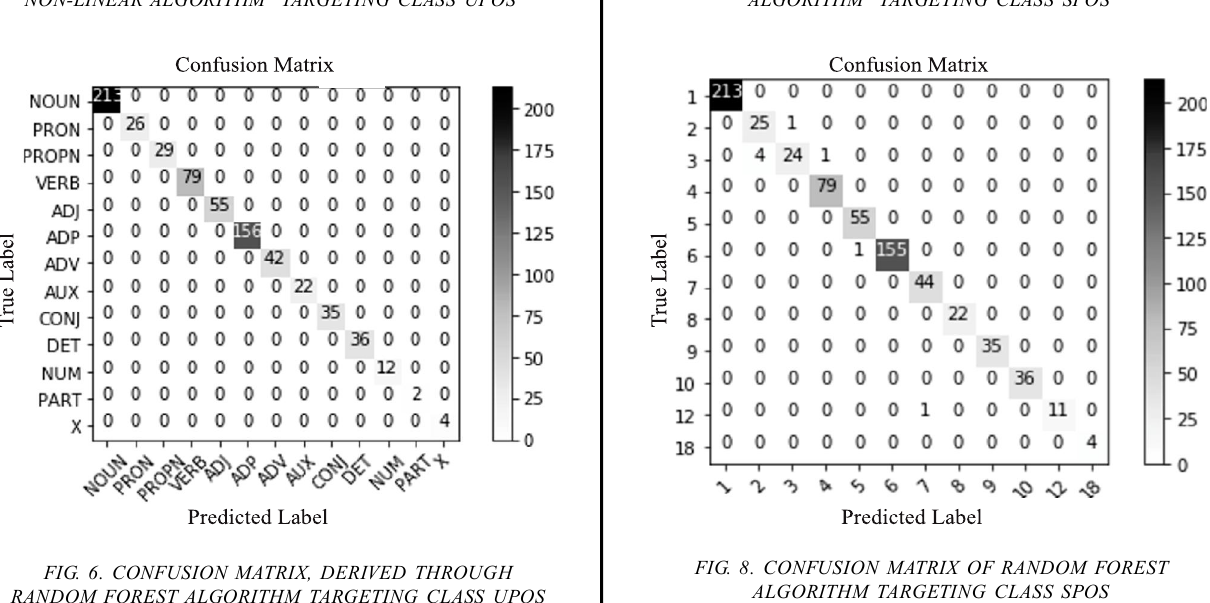
FIG. 5. CONFUSION MATRIX , DERIVED THROUGH SVM NON-LINEAR ALGORITHM TARGETING CLASS UPOS